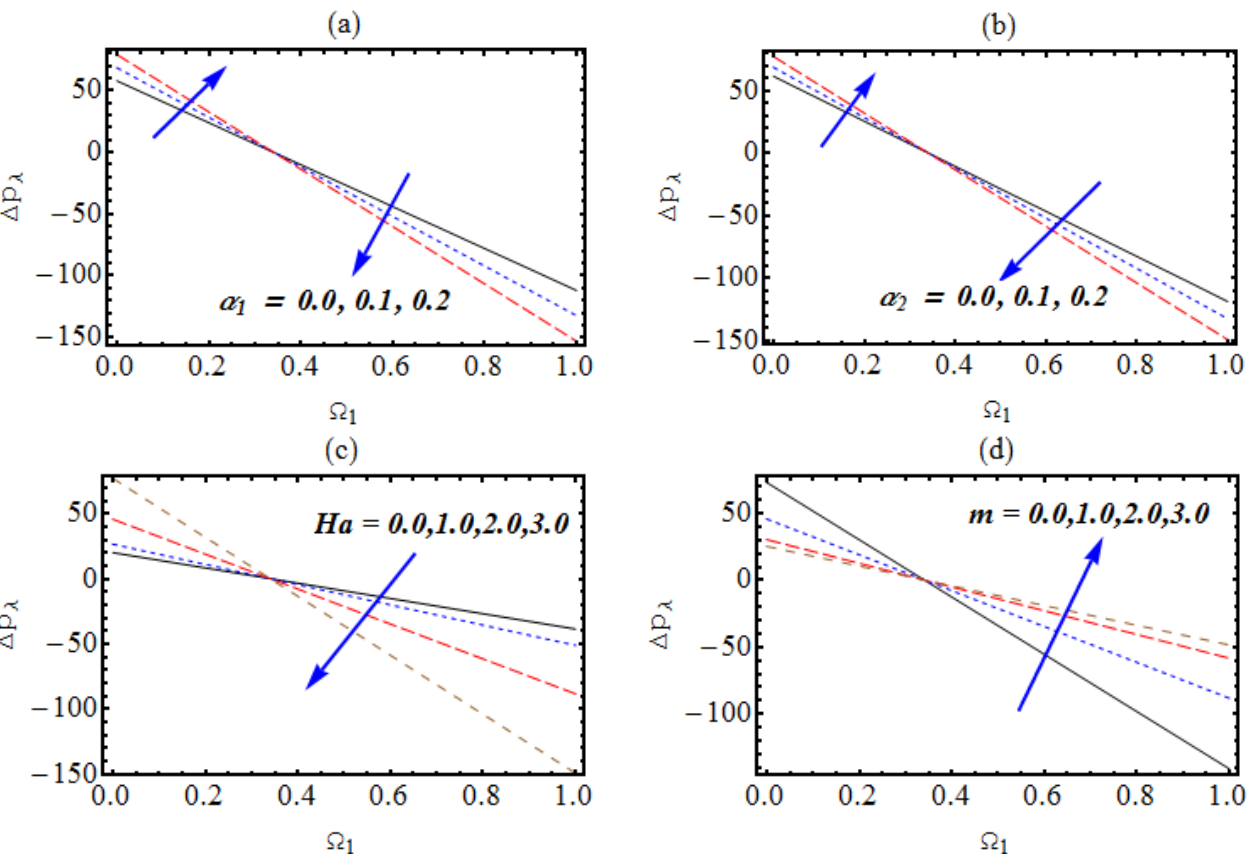
Figure 7. Stream lines for ( a ) m 1 = 0.0 and ( b ) m 1 = 0.1 where the other parameters are α 2 = 0.1, k = 3.0, Ha = 3.0, q = − 0.1, m = 1.0 and α 1 = 0.05.